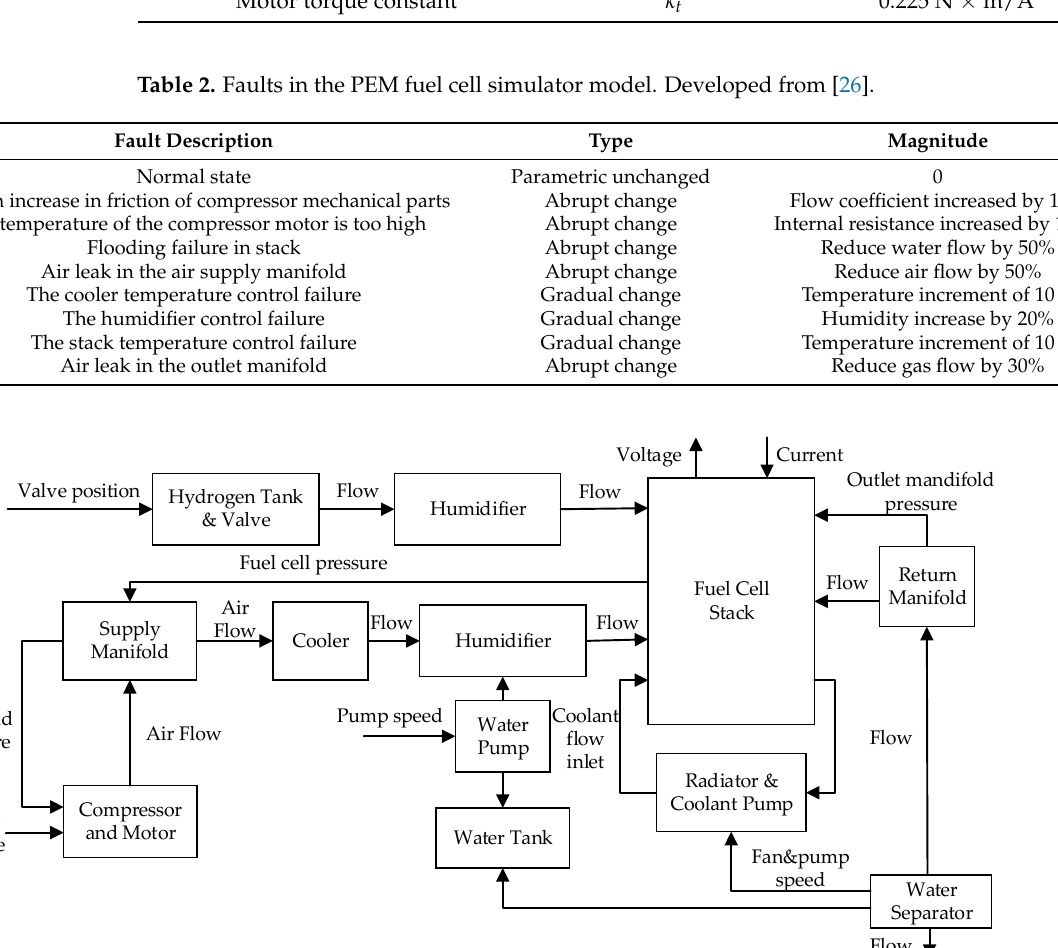
Figure 2. PEMFC system block diagram. Reprinted with permission from Springer-Verlag London 2004, 2021 [22].